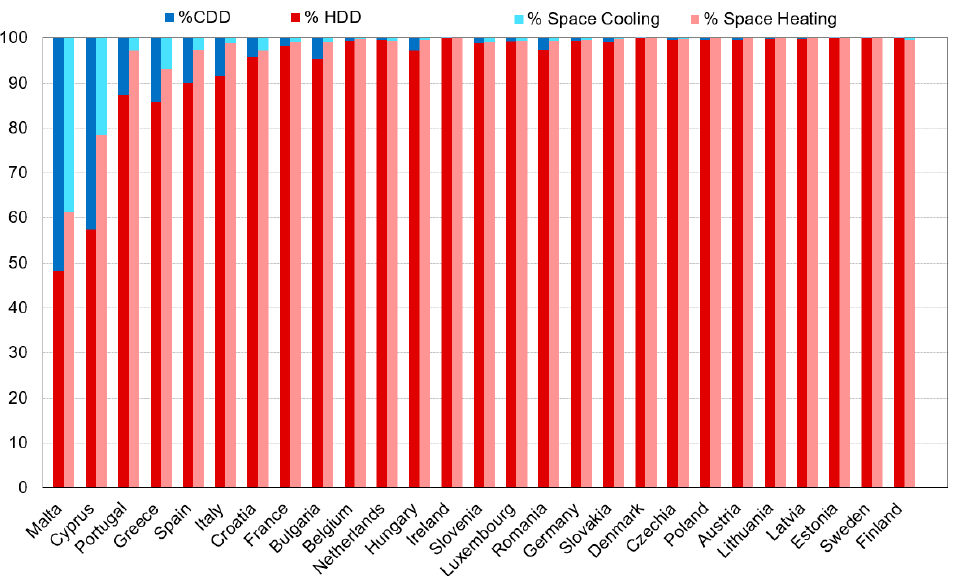
Figure 7. Portion of HDD and CDD (averaged value for the period 1979–2021) for EU-27 countries along with the portion of space H&C demands in households (values from 2020 except for Spain, which is 2019). Source: Eurostat [164].